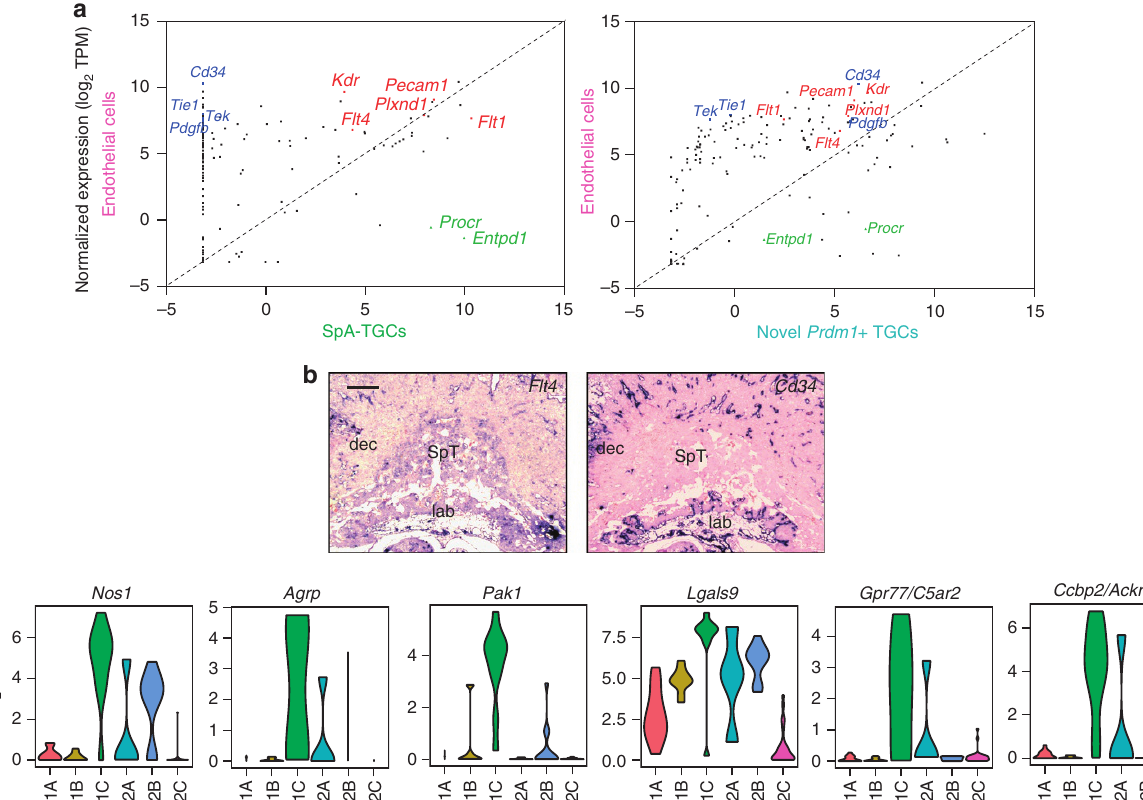
Figure 7 | The transcriptional signatures of SpA-TGCs and endothelial cells only partially overlap. ( a ) Scatter plot of endothelial markers identified by Takase et al. demonstrates that the majority are expressed in allantoic endothelial cells but are not detected in SpA-TGCs. Scatter plot of endothelial cell genes compared to novel Prdm1 þ TGCs (group 2A) reveals detectable expression of almost all endothelial markers in novel Prdm1 þ TGCs. Plotted are median gene expression values within each group. ( b ) ISH reveals widespread expression of the endothelial marker Flt4 throughout trophoblasts, but more restricted Cd34 expression. Bar, 200 m m. ( c ) Genes enriched in SpA-TGCs are involved in immune tolerance, hormone signalling, vasodilation and trophoblast